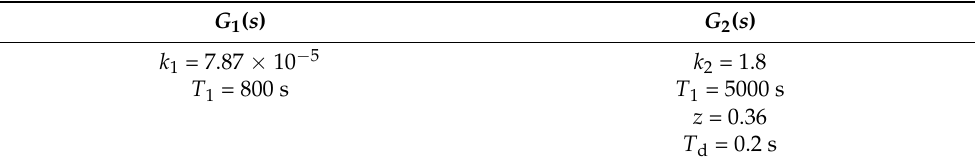
Table 3. Identified parameters of the temperature-dependent